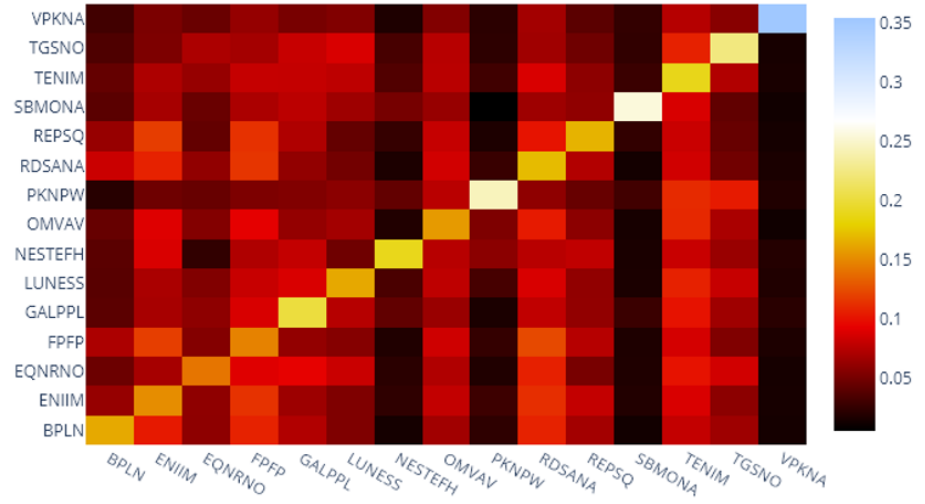
Figure 3. Spillovers across companies inside the energy sector for MES measures — full sample.